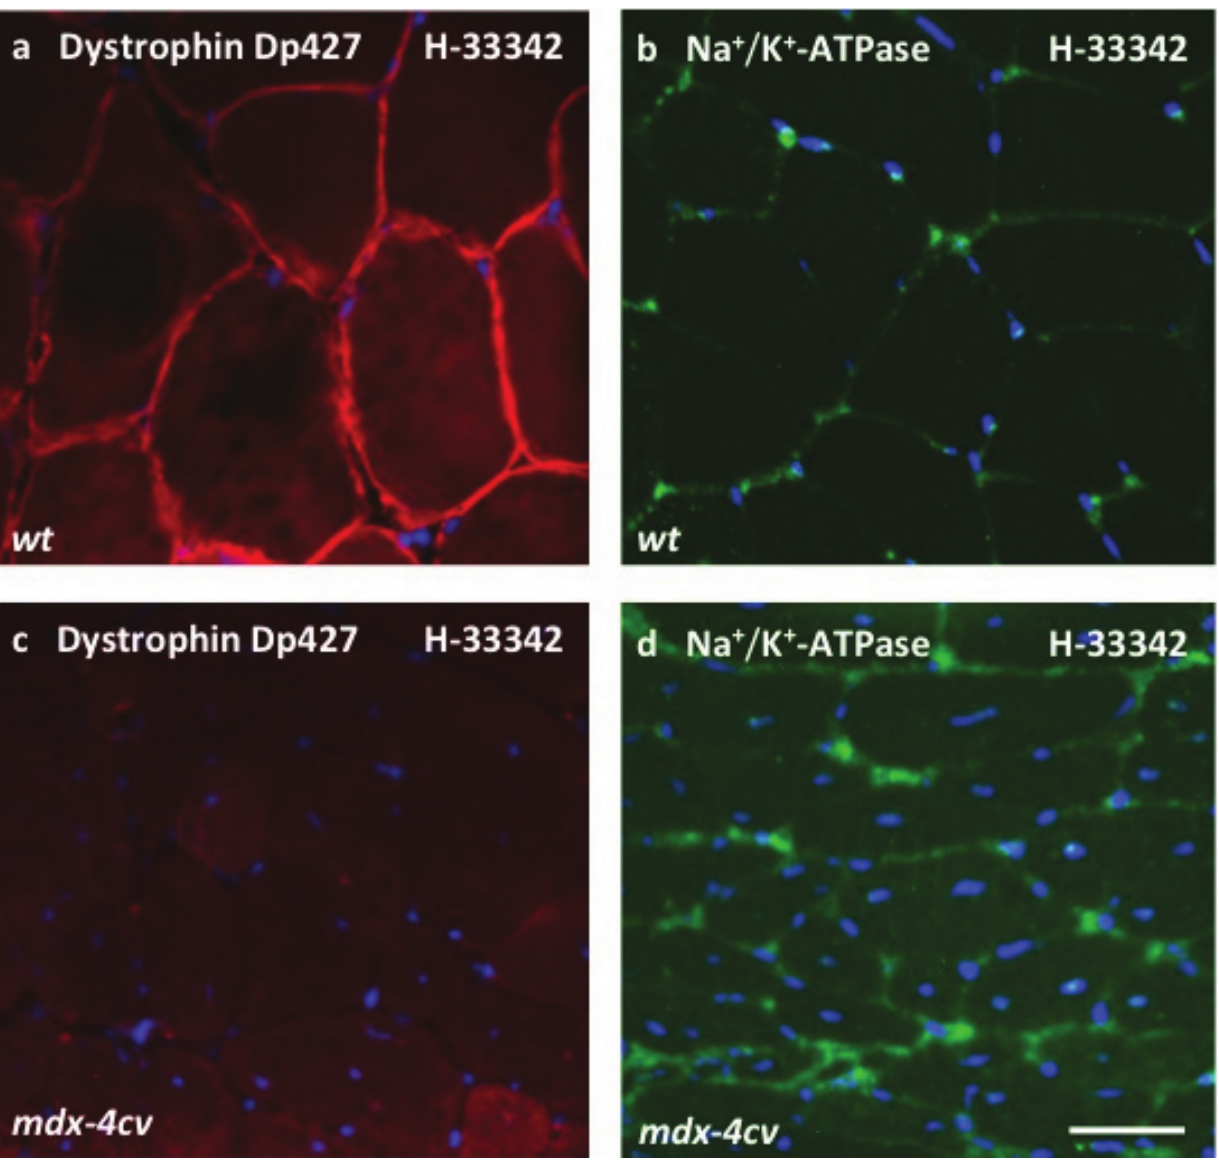
Figure 7. Immunofluorescence microscopical analysis of dystrophin and the Na + /K + -ATPase in mdx-4cv gastrocnemius muscle. Shown is the labelling of nuclei with the DNA binding dye bis-benzimide Hoechst 33342 (H-33342) ( a – d ), as well as antibody labelling of the full-length dystrophin isoform Dp427 ( a , c ) and the Na + /K + -ATPase ( b , d ) in wild type ( wt ) ( a , b ) versus dystrophic mdx-4cv ( c , d ) gastrocnemius muscle. The immunofluorescence microscopical analysis of dystrophin-deficient muscle fibres indicates a higher degree of central nucleation and increased levels of the sarcolemmal Na + /K + -ATPase. The bar equals 20